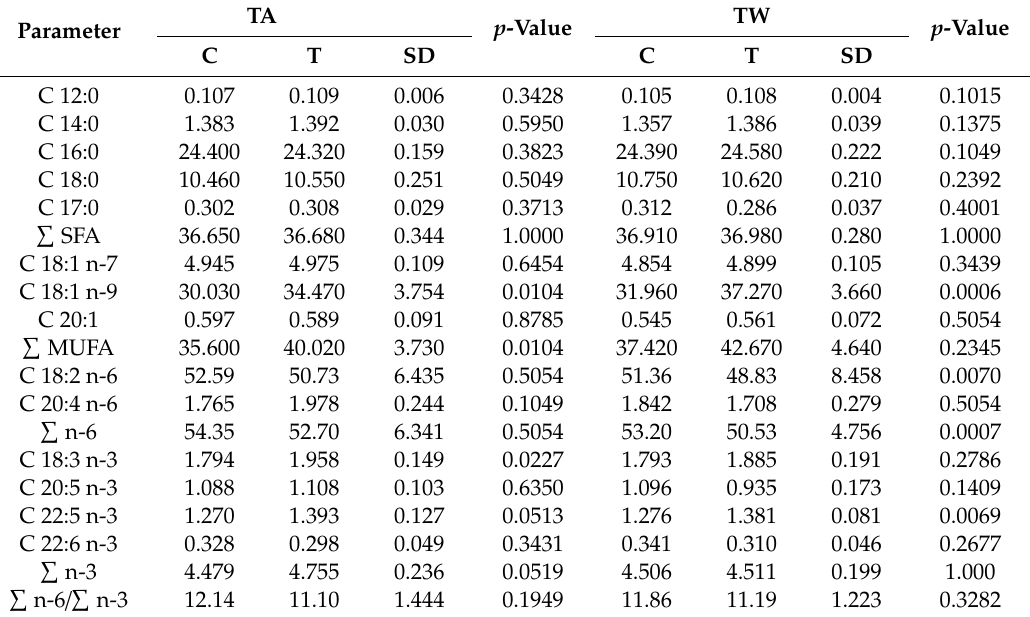
Table 5. E ff ects of thymol on fatty acids profile (% of total FA) in rabbit